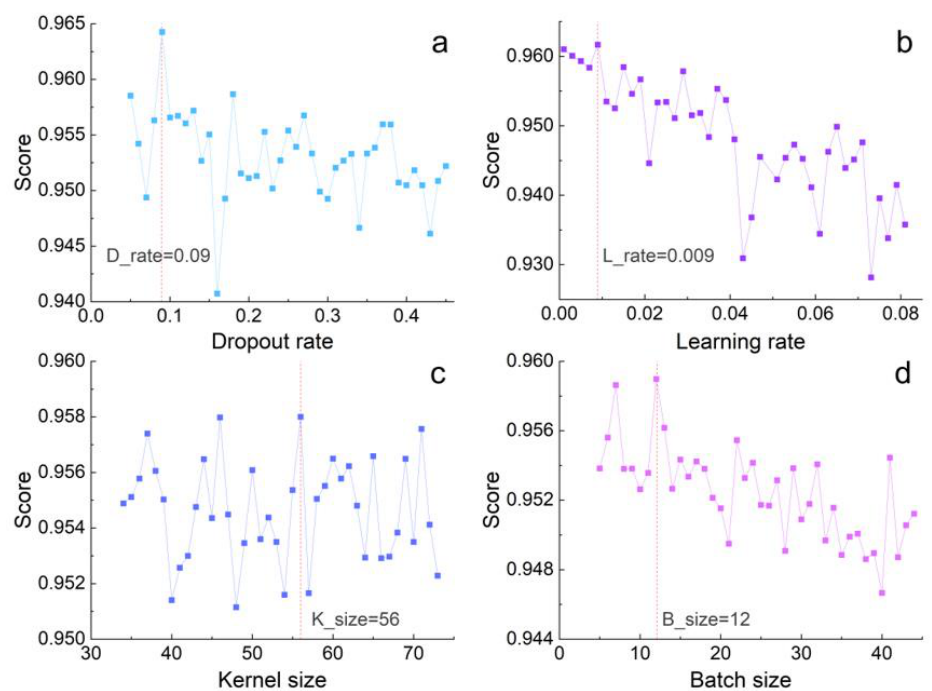
Figure 14. The test accuracy of the different hyperparameter settings in the CNN model. ( a ) Dropout rate; ( b ) Learning rate; ( c ) Kernel size; and ( d ) Batch size. The red vertical line indicates the best parameter value when the score is highest.